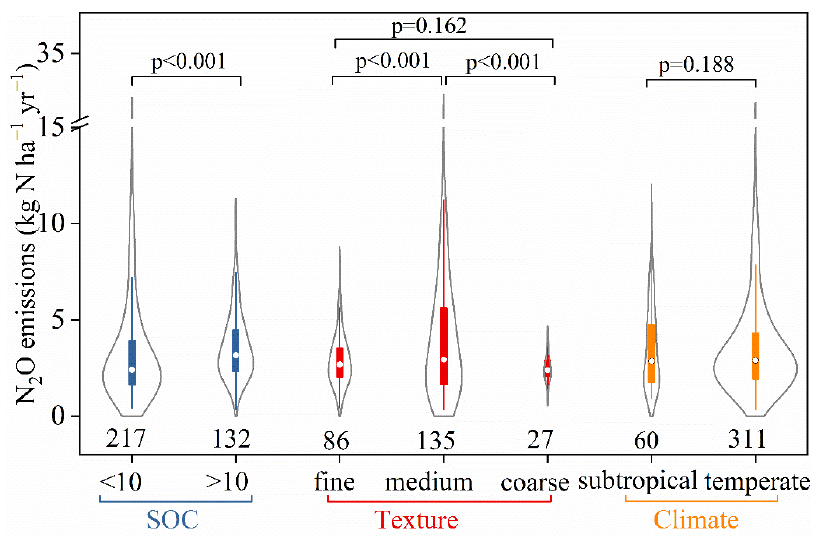
Figure 3. Comparison of N 2 O emissions (kg N ha − 1 yr − 1 ) between the groups according to soil organic carbon (SOC) content (g C kg − 1 ), texture, and climate. The circle point, box, and bar denote the median, 25% and 75% quantiles, and 1.5 interquartile ranges, respectively.